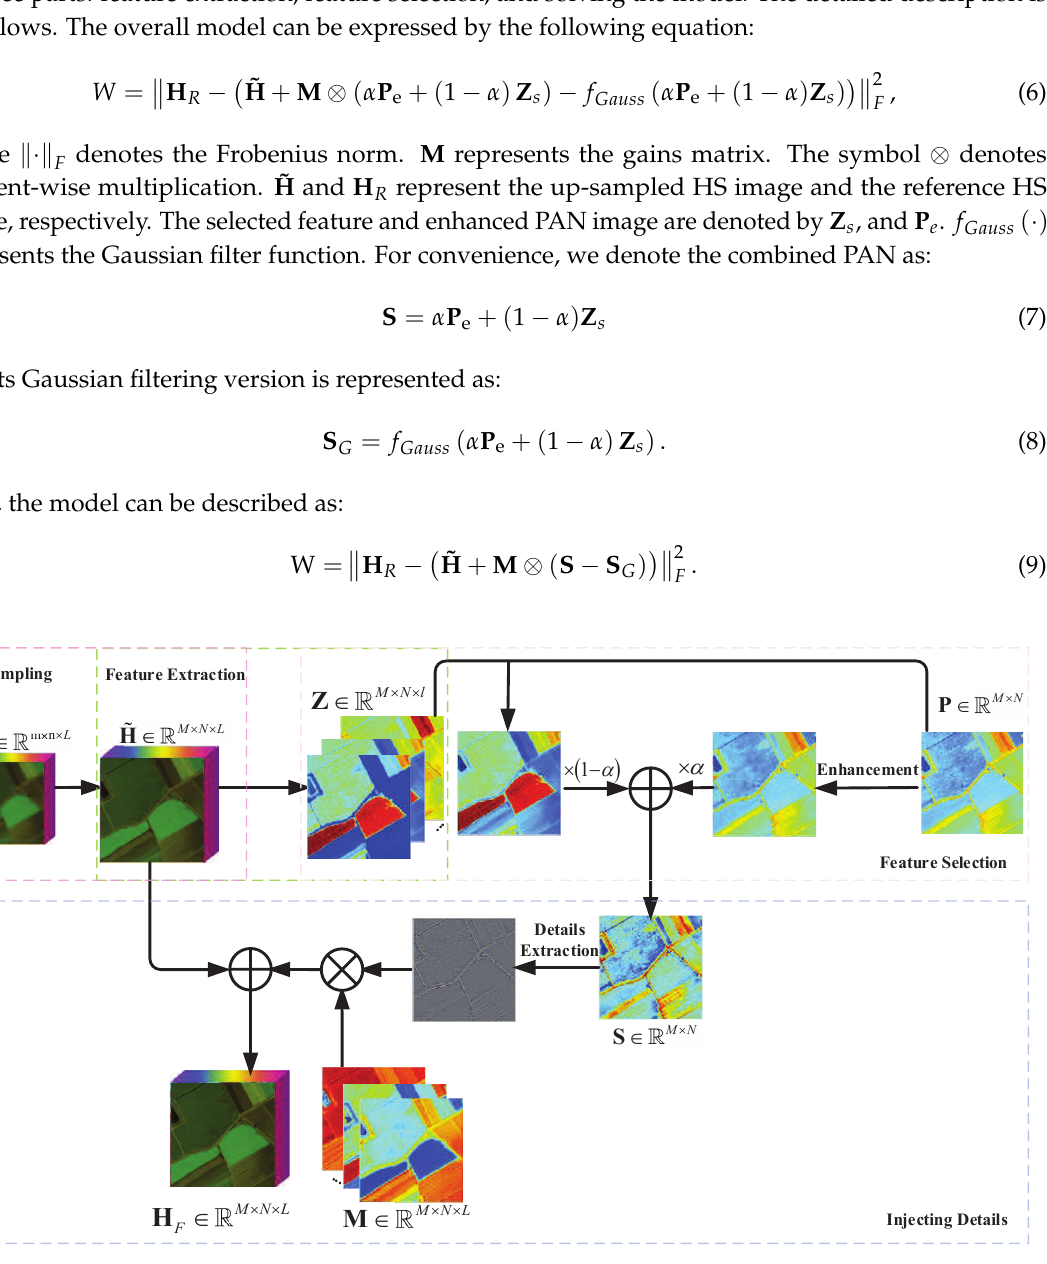
Figure 1. The overall flowchart of the proposed SCAAE based pansharpening